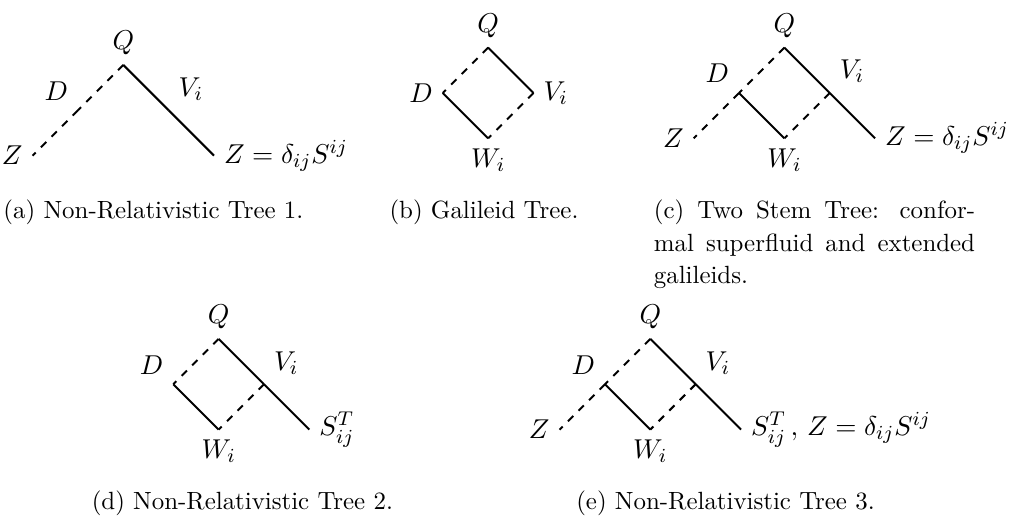
Figure 3. Level-2 Inverse Higgs